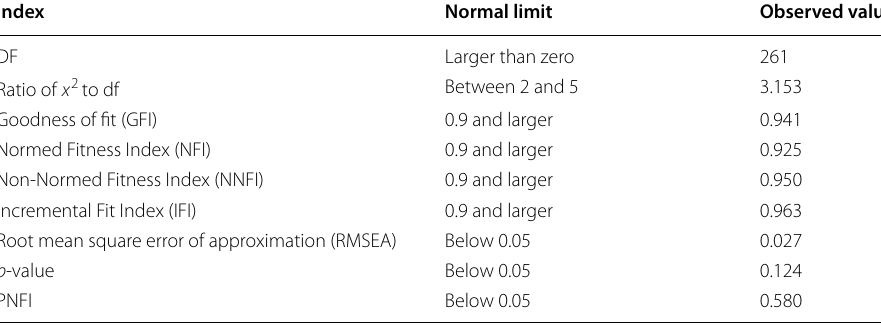
Table 2 Overall fit indicators for the conceptual model